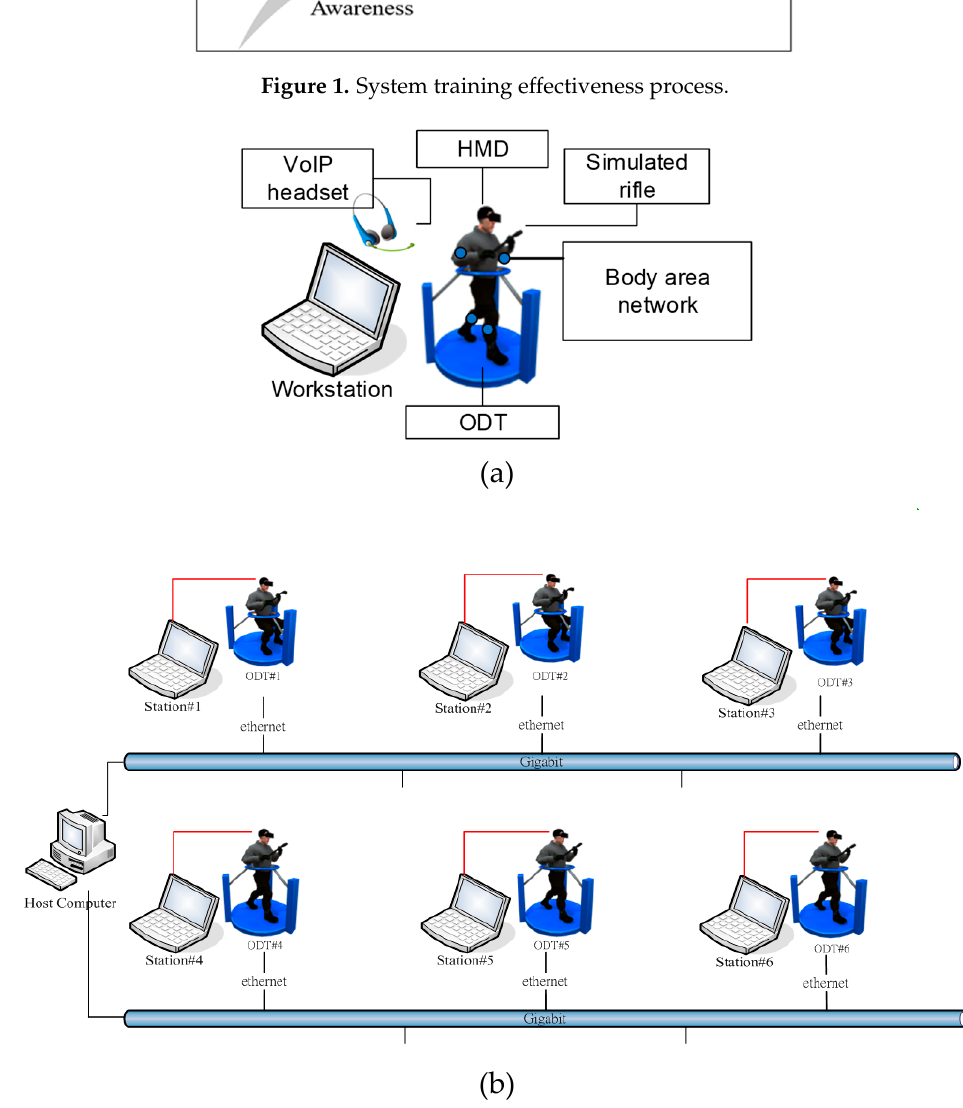
Figure 2. System architecture: single-soldier layout ( a ); multi-soldier network ( b ).